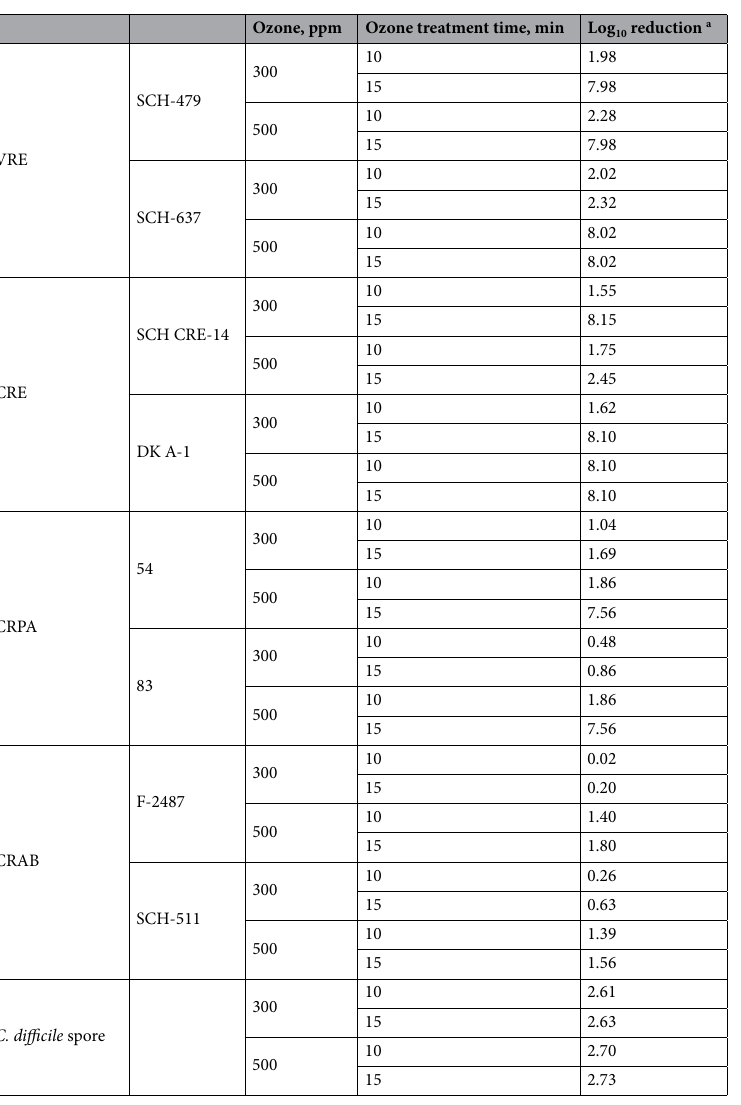
Table 1. Effects of ozone on bacterial kill of VRE, CRE, CRPA, CRAB and C. difficile on agar plates. VRE vancomycin-resistant enterococci , MRPA multidrug-resistant Pseudomonas aeruginosa , MRAB multidrug- resistant Acinetobacter Baumanii , CRE carbapenem-resistant Enterobacterales a numbers of colony-forming units per milliliter of test